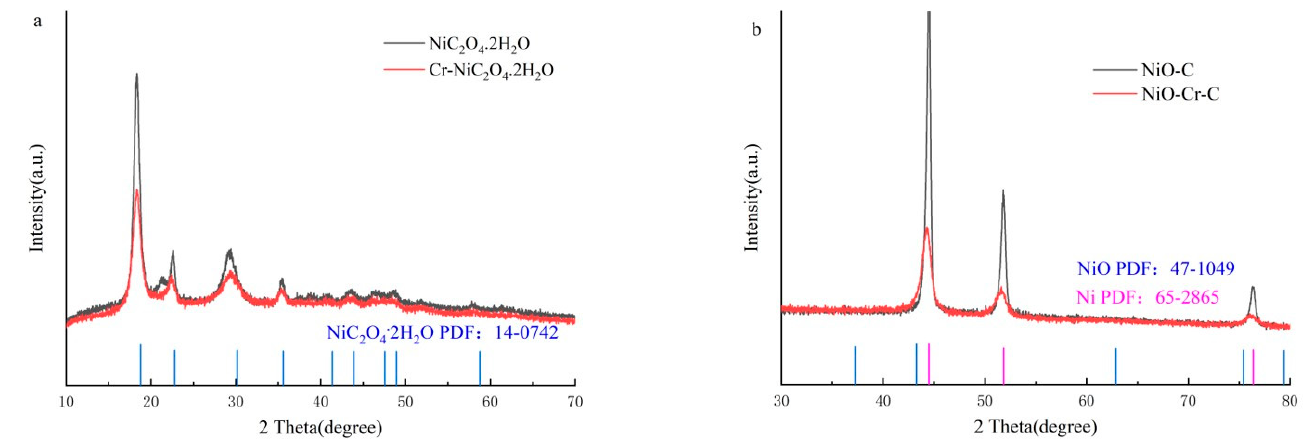
Figure 1. The XRD patterns of the as-prepared composites ( a ) before annealed, ( b ) after